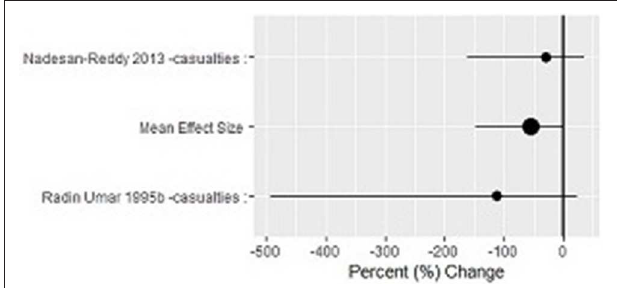
FIGURE 5 | Primary outcome: percent change in the number of ‘road accident casualty’ after road engineering interventions.